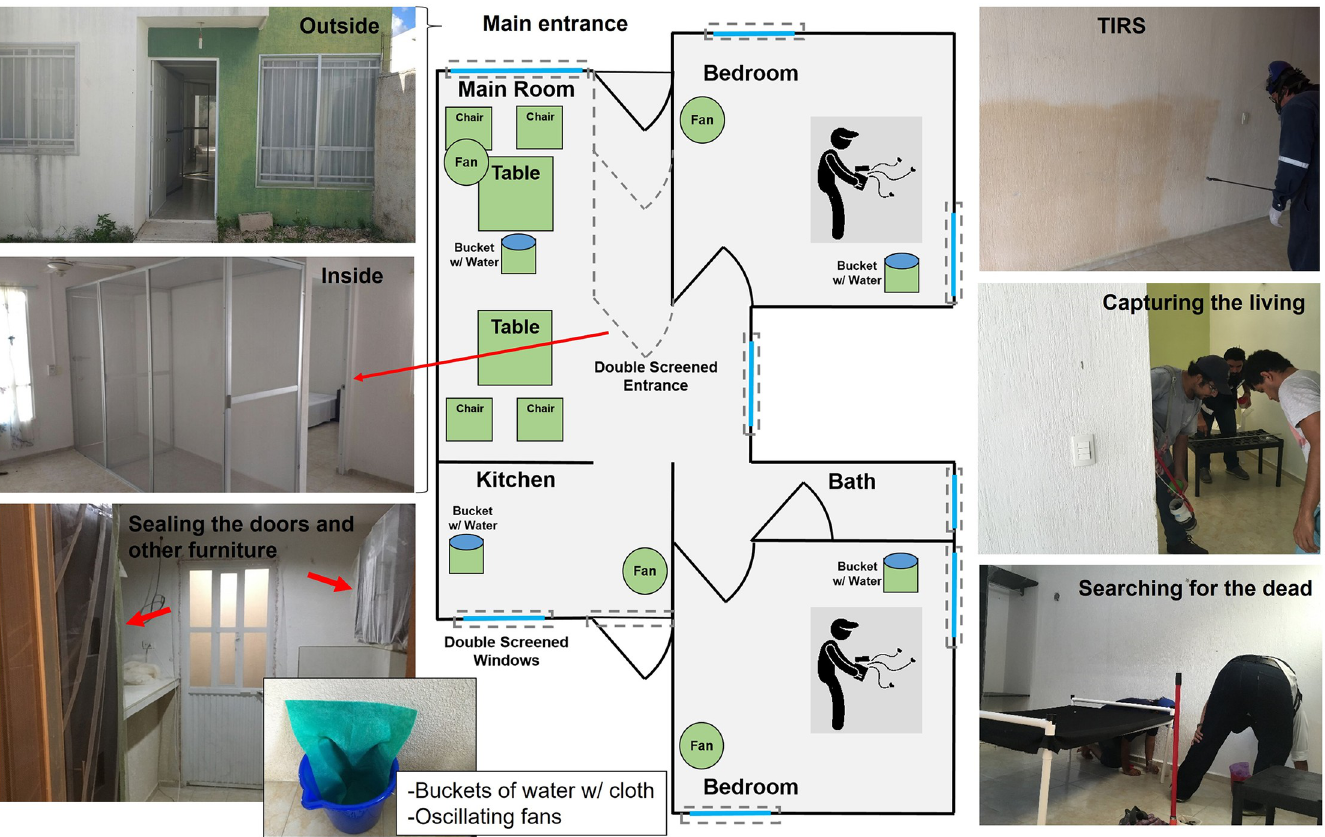
Fig 1. Experimental houses from Merida, Mexico. Two houses with similar area (size: 144.5 ± 7.12 m3) and layout were used. Windows and doors (inside & outside), including furniture were sealed. A double screened entrance was also installed. Simulated furniture was standardized in each house. Buckets of water with cloth piece and oscillating fans were installed to keep optimal humidity and temperature as showed in the